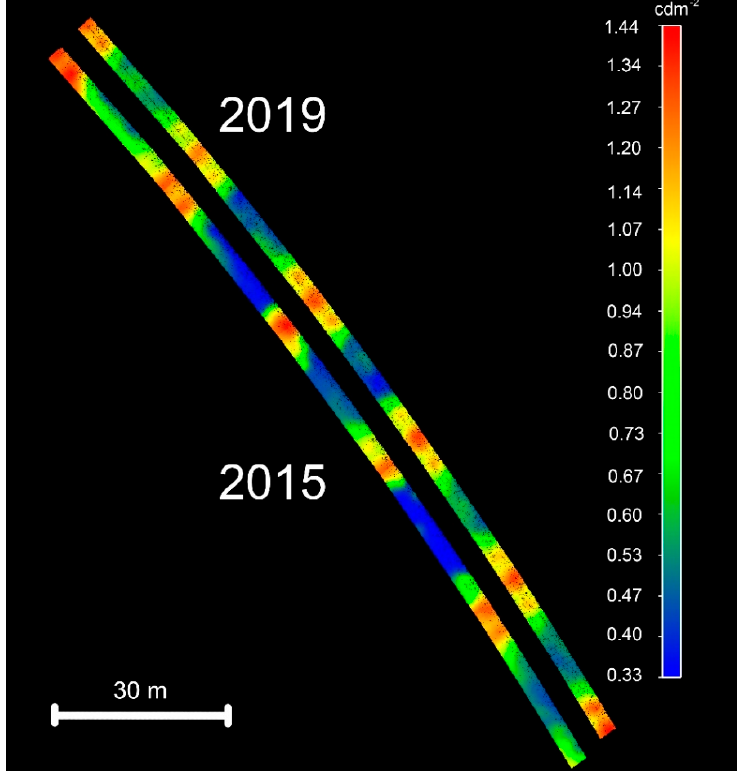
Figure 2. Pseudo-coloured luminance values on the road surface for the whole area of measurement before (2015) and after (2019) tree pruning.